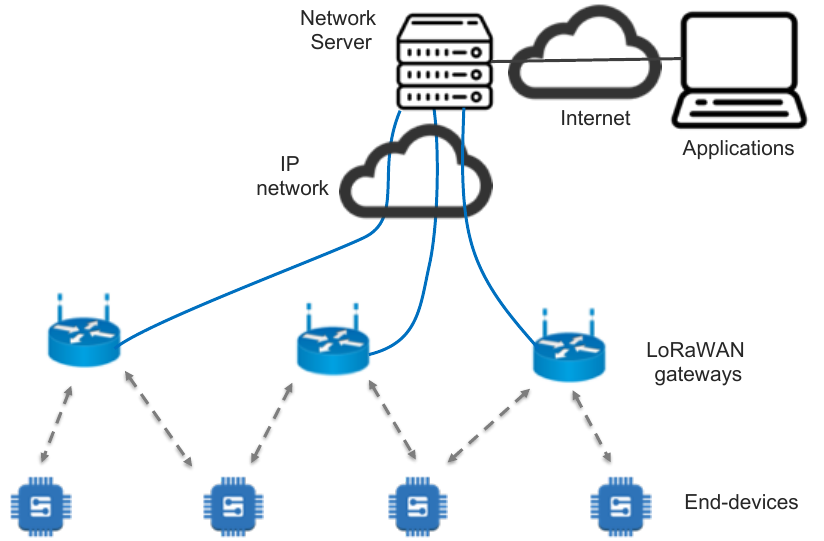
Figure 1. The architecture of a generic Long Range Wide Area Network (LoRaWAN)